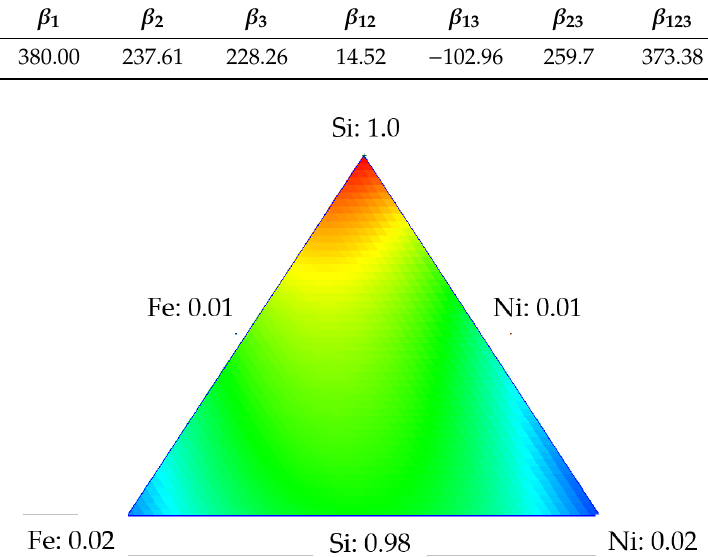
Figure 2. Response surface for the surface area of the design using Si-Fe-Ni.